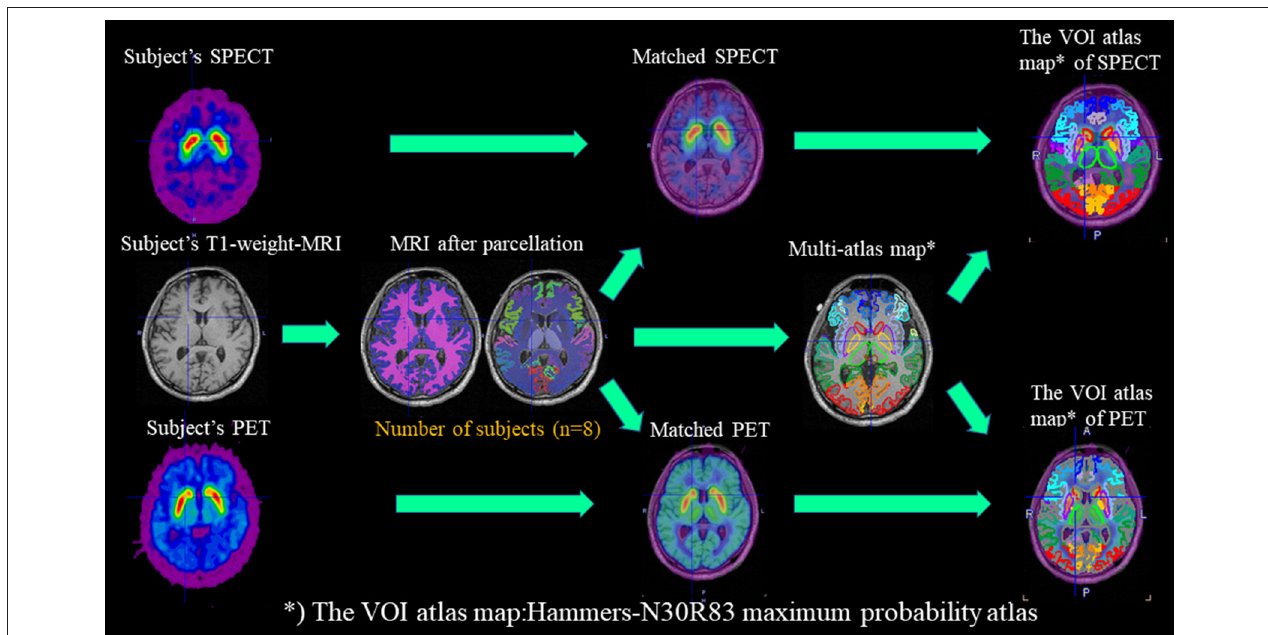
FIGURE 1 | Workflow for studies with DAT-SPECT/PET and T1-MRI in PNEURO. In the workflow, subject-specific images (DAT-PET and DAT-SPECT) and MRI images after parcellation with eight normal subjects are matched, and multi-atlas maps are generated.